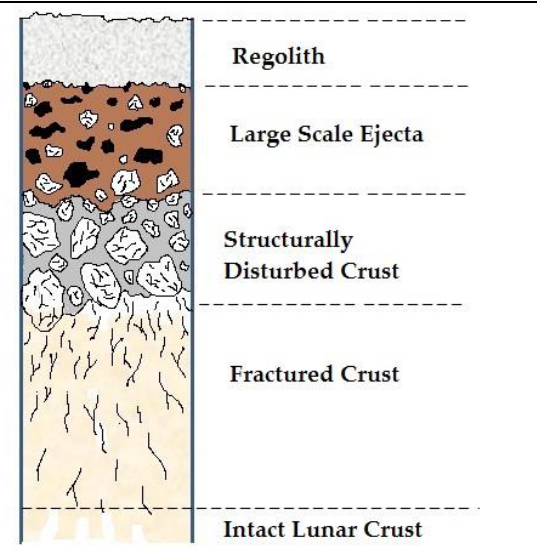
Figure 1. An idealized vertical profile of the lunar mega-regolith and